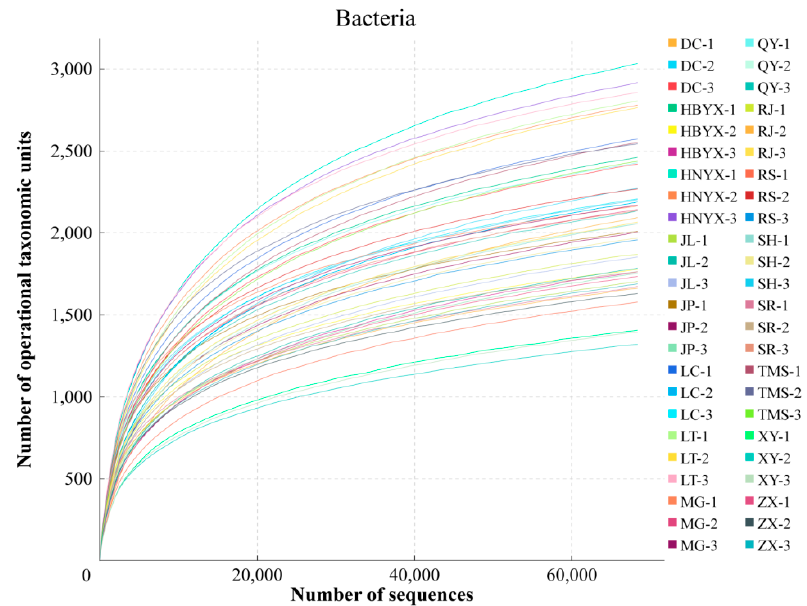
Figure 2. Rarefaction curves of bacteria established based on 97% similarity.